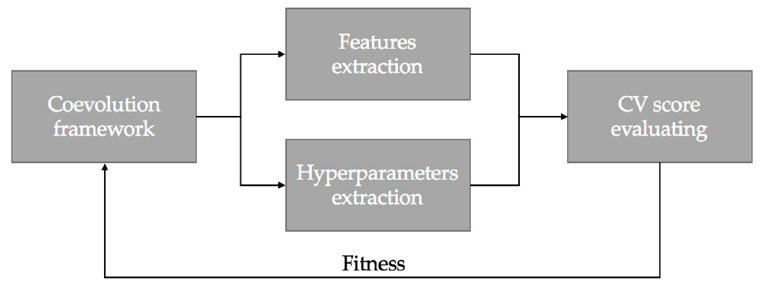
Figure 7. Evolving the hyperparameters and features via cooperative coevolution (CC).